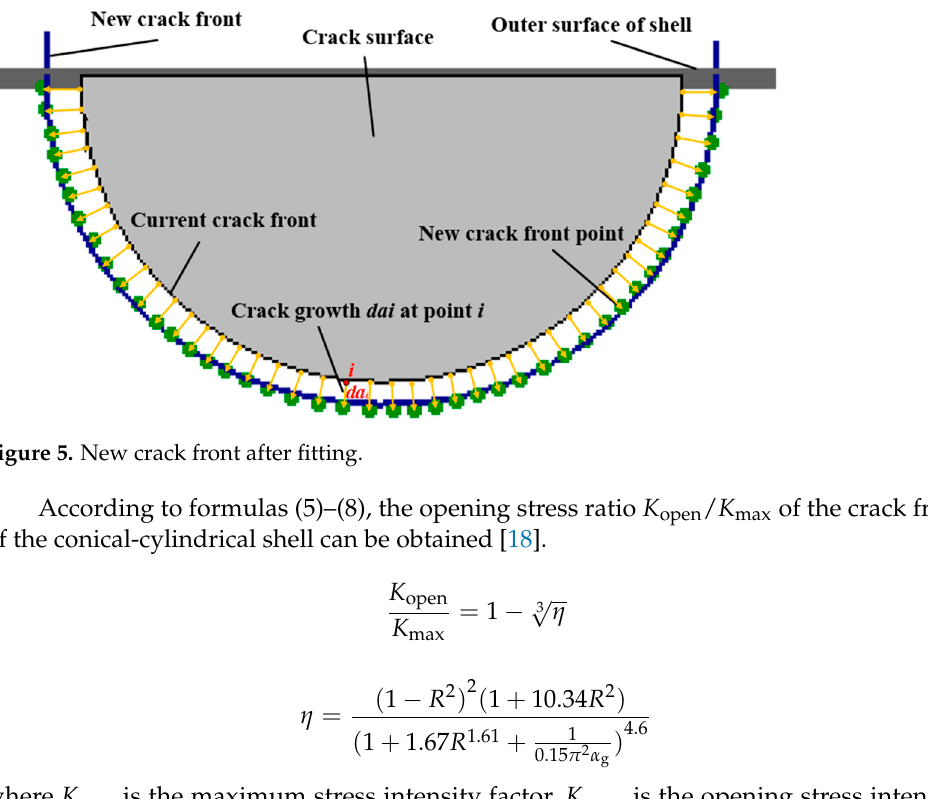
Figure 5. New crack front after fitting.